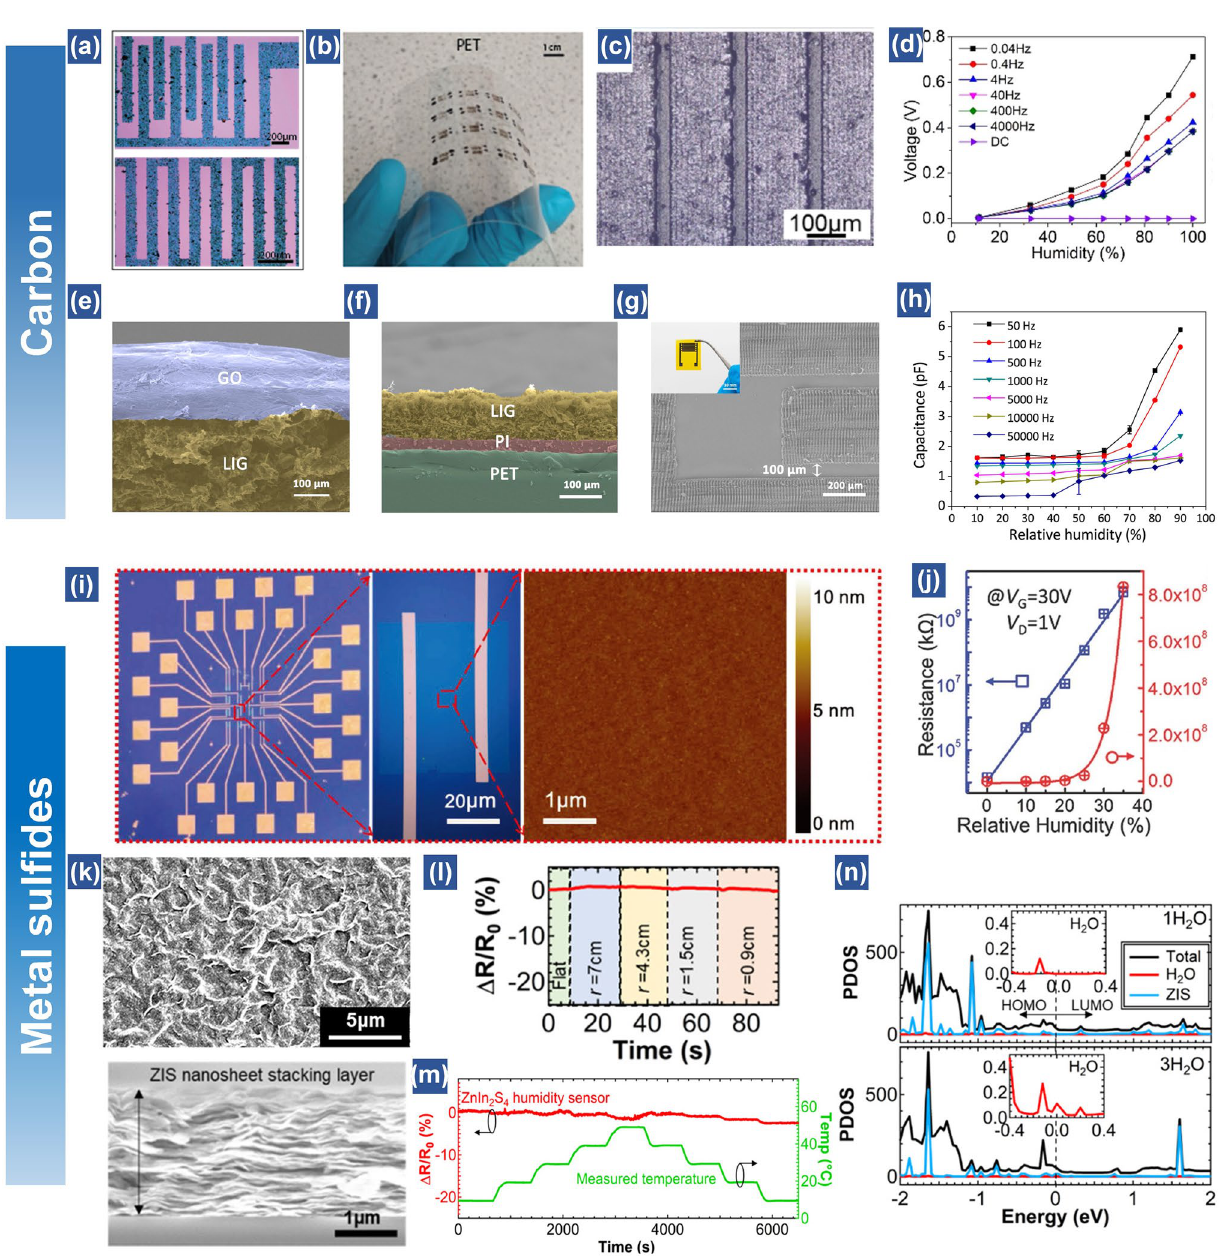
Fig. 3 Carbon materials-based and Metal sulfides-based flexible humidity sensors. ( a ) Optical microscope image of the resulting graphene pat- tern. ( b ) All-graphene devices built on PET substrate with carbon paste contacts (all-carbon devices) [96]. Copyright 2019 Wiley. ( c ) Interdigi- tated pattern of rGO/GO/rGO prepared on a flexible PET film and corresponding optical microscope image. ( d ) The change of the sensing peak voltages toward RH at different frequencies [97]. Copyright 2018 ACS Publications. ( e ) Cross-sectional SEM image of the GO-based sensor. ( f ) Cross-sectional SEM image of the PI-based sensor. ( g ) SEM images of the PI-based sensors showing finger spacing of 100 μm. ( h ) Relationship between capacitance and RH at different frequencies of the PI-based humidity sensors using LIG-IDEs with finger spacing of 100 μm [98]. Cop- yright 2020 Elsevier. ( i ) A typical 3D AFM image showing the edge of the WS 2 film on the SiO 2 /Si substrate. Black line: A typical height profile showing the thickness of the WS 2 film. ( j ) Response of the sensor in different relative humidities. Inset: The magnified curve of the low RH region from 20 to 45% [104]. Copyright 2017 Royal Society of Chemisty. ( k ) SEM images of surface and cross-sectional views of the ZnIn 2 S 4 film. ( l ) Bending test of the flexible ZIS humidity sensor under RH 30%. ( m ) Temperature dependence test of the ZIS humidity sensor under temperature change from 10 to 50 ℃ at RH 30%. The temperature was measured by a commercial temperature sensor in the oven. ( n ) Structural configuration of the simulation model. Projected density of states (PDOS) with 1H 2 O and 3H 2 O at a bias of 3.3 V [44]. Copyright 2020 ACS